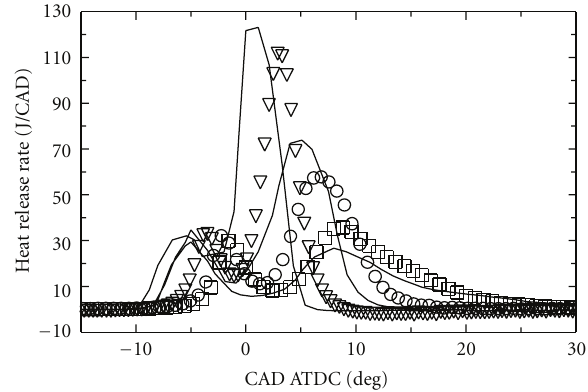
Figure 8: Comparison of heat release rates versus crank angle degree after top dead center (CAD ATDC). Symbols: experimental data from a CFR engine with di ff erent equivalence ratios ( φ ): (cid:2) ( φ = 0 . 358); (cid:2) ( φ = 0 . 317); ( φ = 0 . 277); Lines: 28-species (cid:3) reduced DME chemistry (this work).